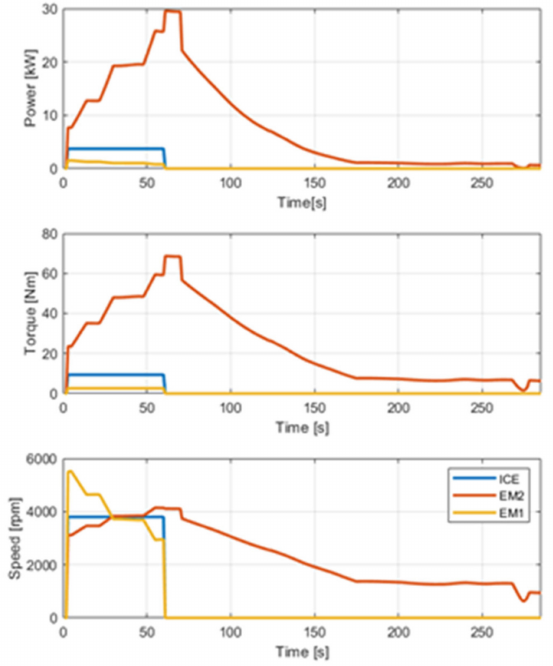
Figure 16. The behavior of the power-split system in case of engine